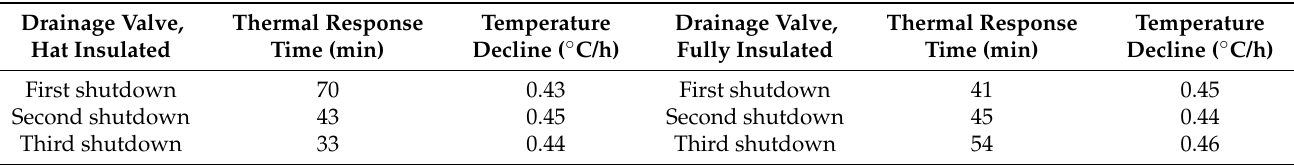
Table 4. Thermal response time and slope of temperature decline during cooling for the drainage valve; data for hat insulation from previous tests